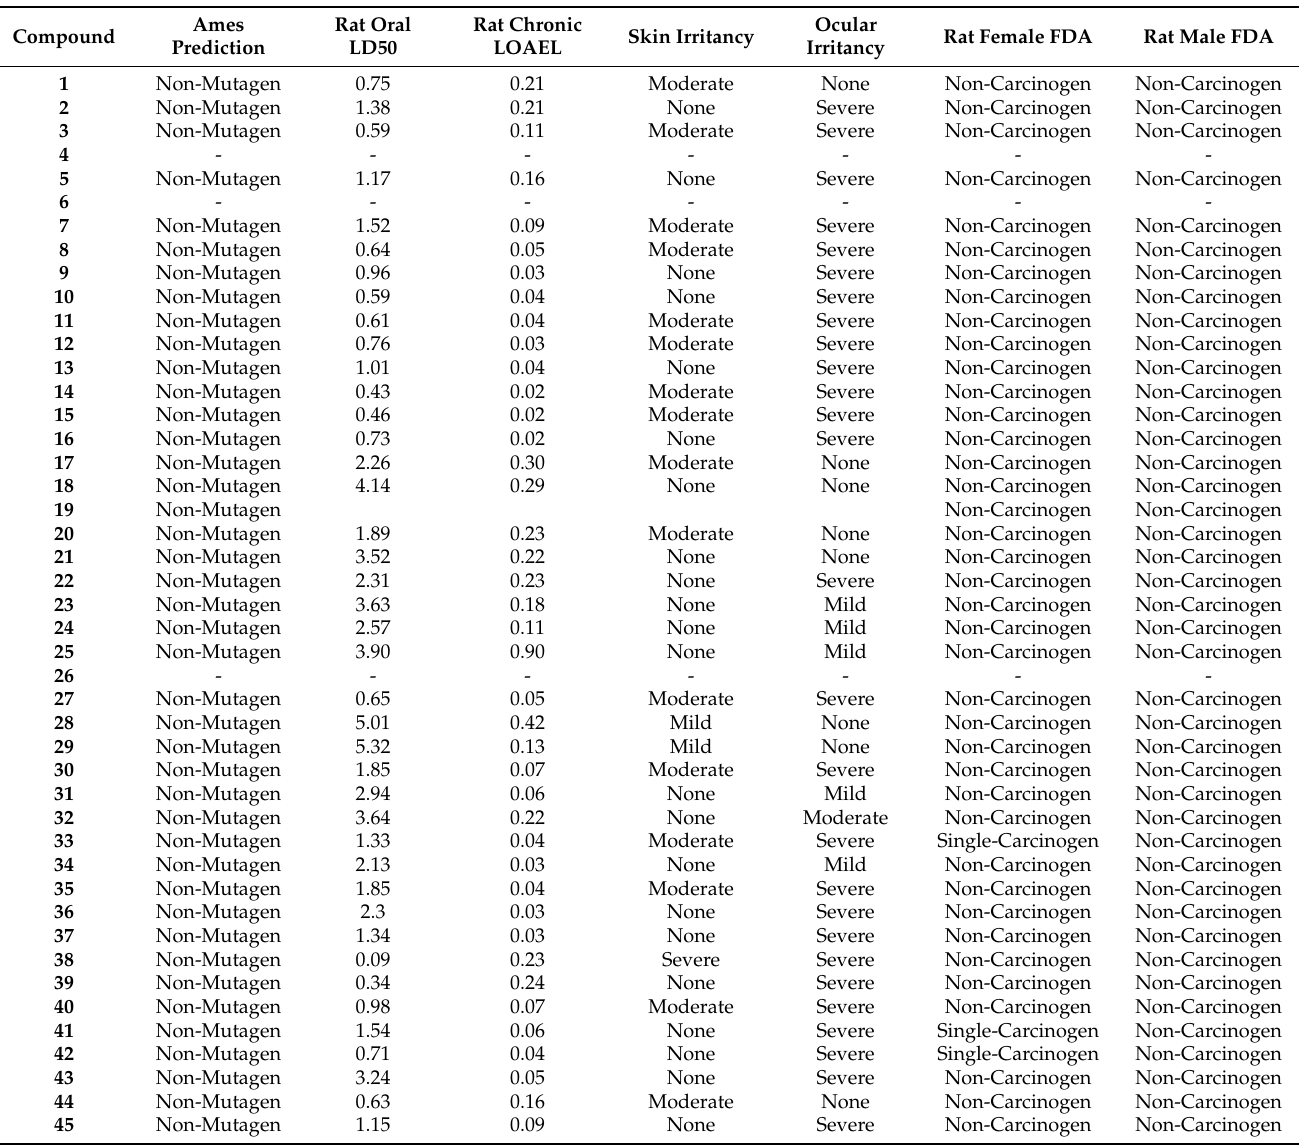
Table 3. TOPKAT prediction of the tested cannabinoids using drug discovery